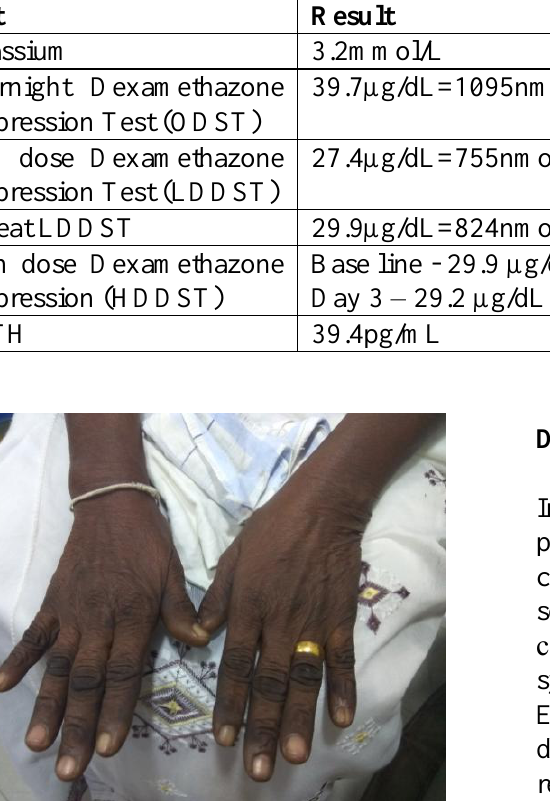
Figure 1: Hyper-pigmentation of hands Brain MRI with dynamic studies did not show any pituitary lesions. Inferior petrosal sinus sampling (IPSS) was consistent with ectopic ACTH